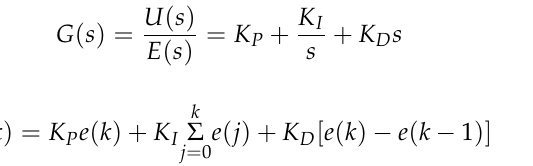
Figure 6. Model of cu tt er height adjustment system from the ground.